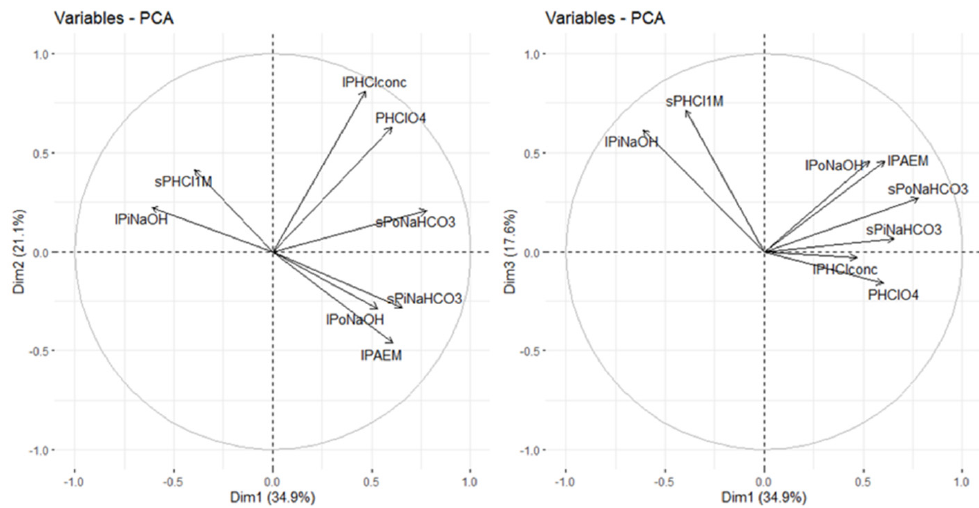
Figure 2. Variables plot for the first (Dim1), second (Dim2) and third (Dim3) components of the Principal Component Analysis based on the soil P fractions.